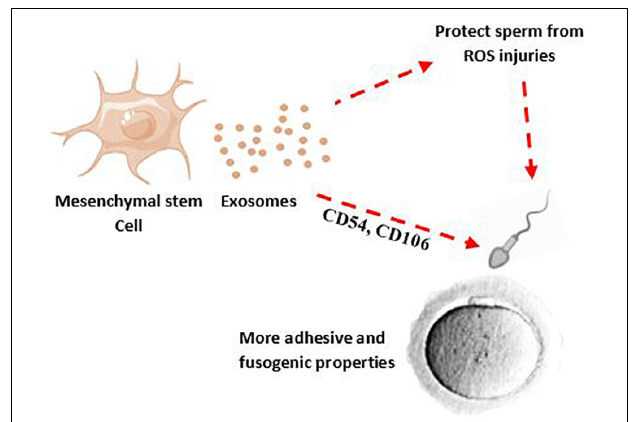
FIGURE 2 | MSC-derived exosomes may decrease ROS production after chlamydia infection and their effects on sperm membrane and DNA. Therefore, MSCs-derived exosomes can potentially improve quality and adhesive properties of